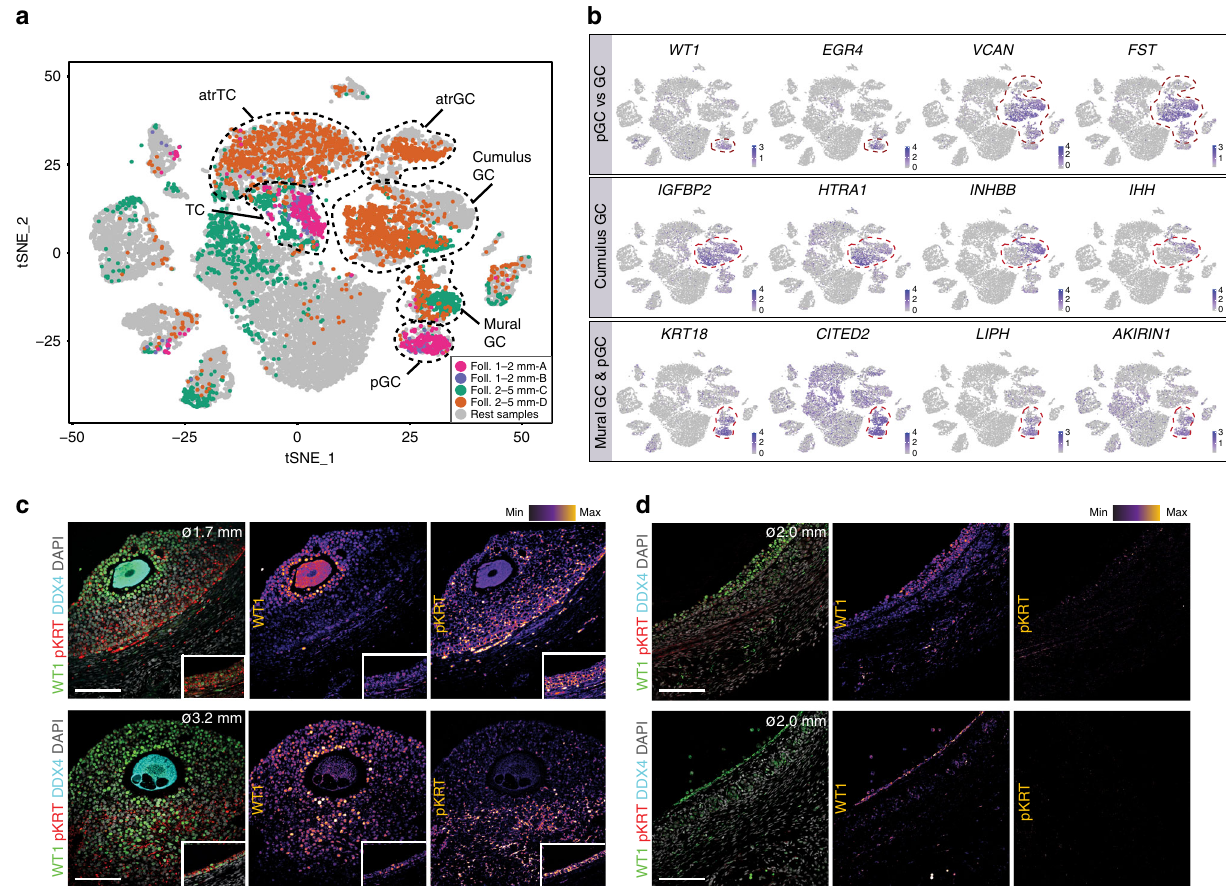
Fig. 4 Divergent populations of granulosa cells in different follicles. a Distribution of single cells from different-sized follicles on the tSNE. Black dashed lines give the boundaries of several clusters of GC (common progenitor GC (pGC), mural GC, cumulus GC, atretic GC (atrGC), theca cells (TC), and atretic TC (atrTC)). b tSNE cluster map showing expression of selected marker genes differentially expressed by GC and pGC (top row), cumulus GC (middle row), and mural GC and pGC (bottom row). Red dashed lines give the boundaries of the GC-clusters of interest. c , d Immunostaining of follicles (ø, diameter) growing ( c ) and atretic ( d ) for WT1 and pan-KRT (pKRT). Inset shows mural GC of the same follicle with the same magni fi cation. Single channel images were converted to an intensity map. Scale bars are 100 μ